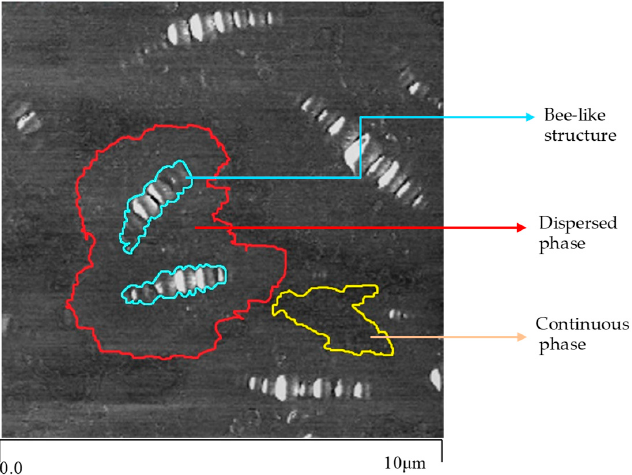
Figure 7. Different phases in the AFM phase image of SBS modified bitumen.